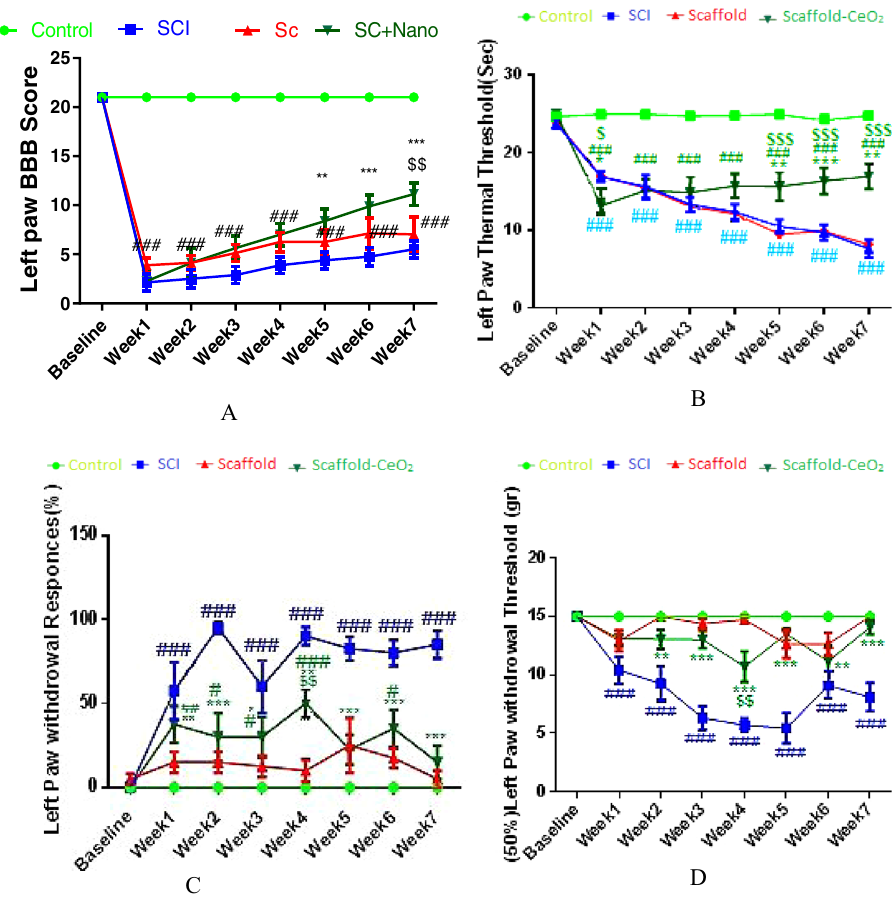
Fig. 2 The effect of Scaffold- CeO 2 and Scaffold implants immediately after SCI induction on left paw functions. A Motor function (BBB), ( B ) Thermal hyperalgesia, ( C ) Cold allodynia, ( D ) Mechanical allodynia. Data is presented as mean ± SEM ( n = 8). In each group * p < 0.05, ** p < 0.01, *** p < 0.001, **** p <